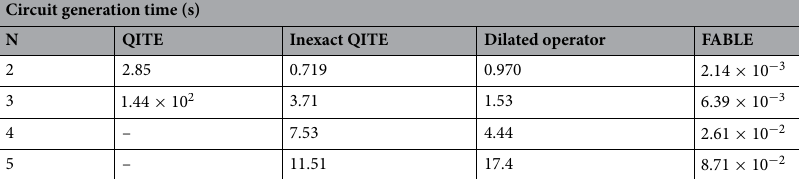
Table 3. Wall-clock circuit generation time at various system sizes N for approximating the imaginary time evolution step of TPQ state preparation with the QITE, inexact QITE, dilated operator, and FABLE algorithms at β = 1